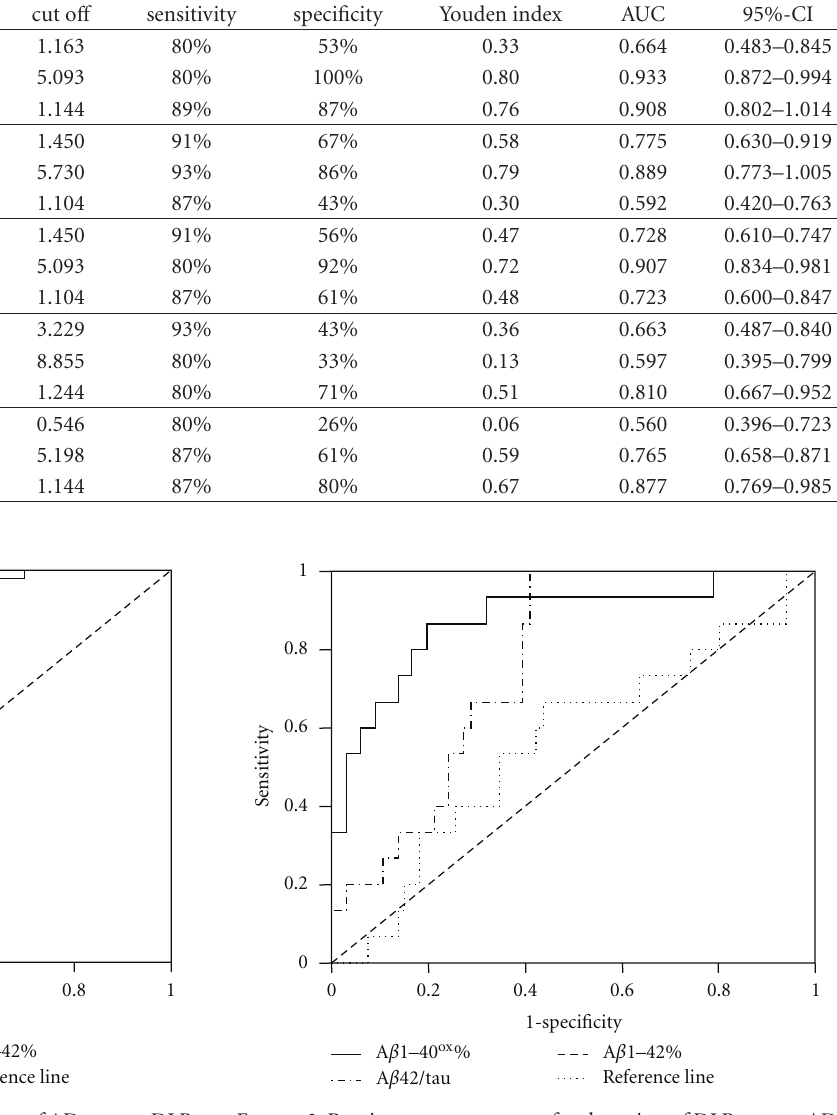
Figure 1: Receiver operator curves for detection of AD among DLB and PDD as a combined group using A β 42/tau, A β 1–42% and A β 1– 40 ox %, respectively.